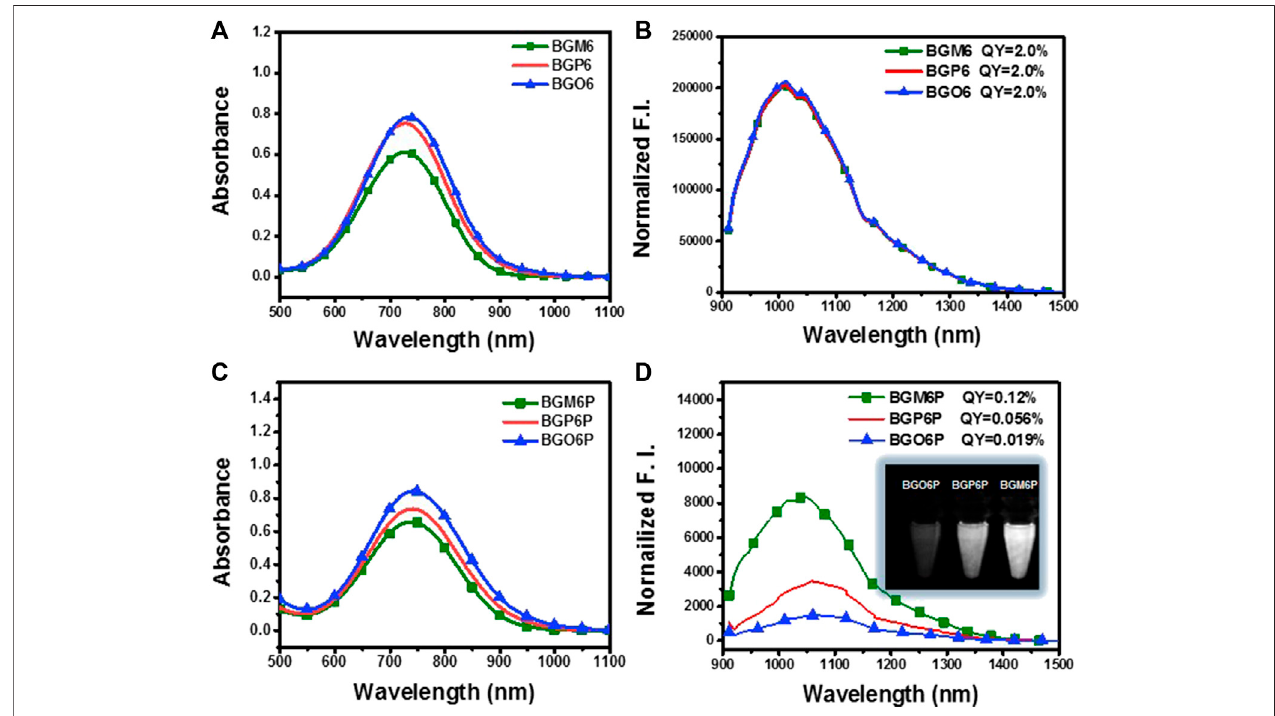
FIGURE 2 | (A) Absorption and (B) emission spectra of un-PEGylated fl uorophores in toluene (40 μ M). (C) Absorption and (D) emission spectra of PEGylated fl uorophoresinwater(80 μ M).An808 nmlaserisusedforexcitationwithexposuretimeof50 ms.The fl uorescenceintensityisnormalizedwiththeopticaldensity(OD)of the sample at 808 nm. The inset of Figure 2D displays the brightness of fl uorophore aqueous solutions under an 808 laser excitation at same concentration.